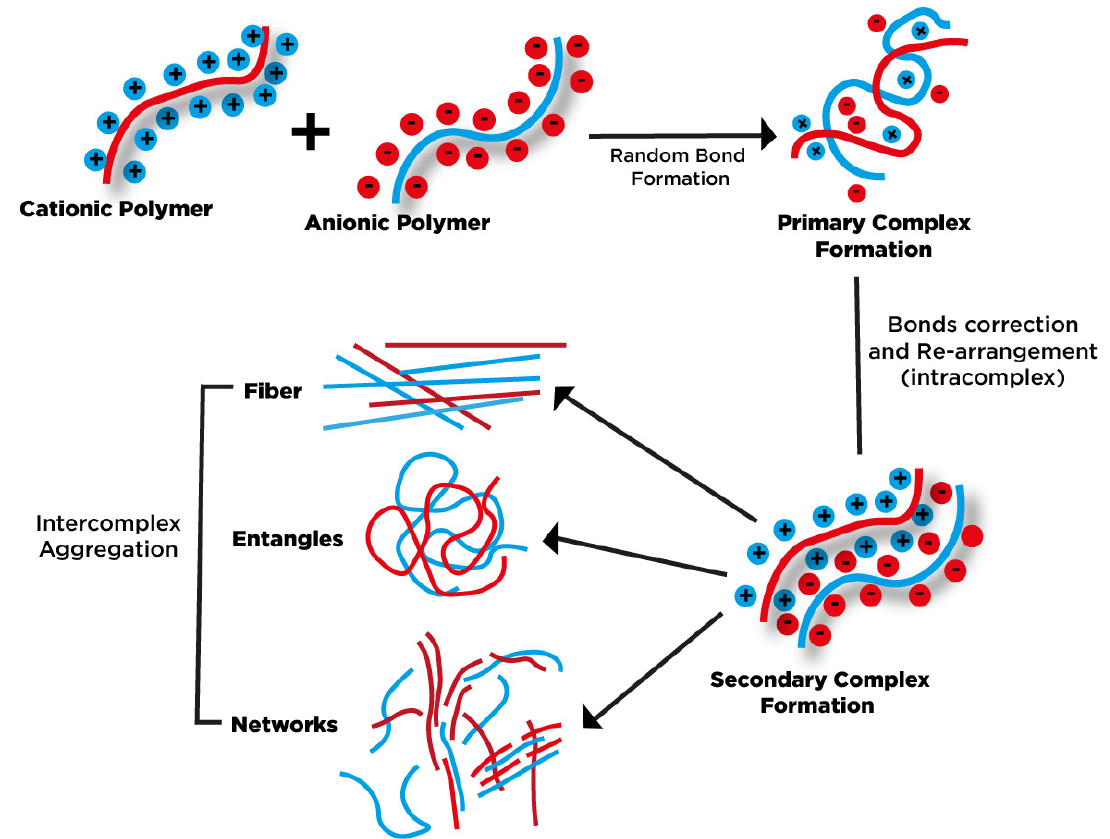
Figure 1. Illustration on the formation of polyelectrolyte complex (adapted from [12]).